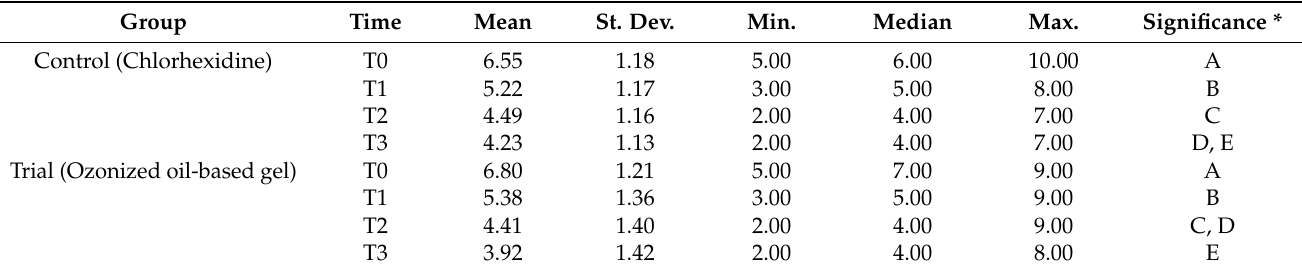
Table 4. Descriptive statistics of Probing Depth (PD)